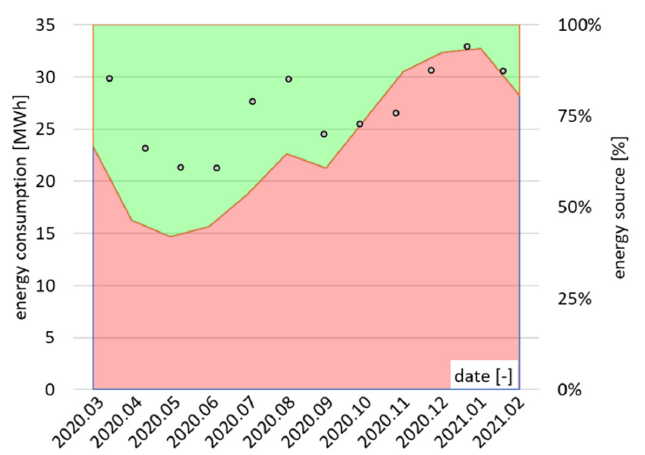
Figure 12. Share of renewable and non-renewable energy sources required to power the building.